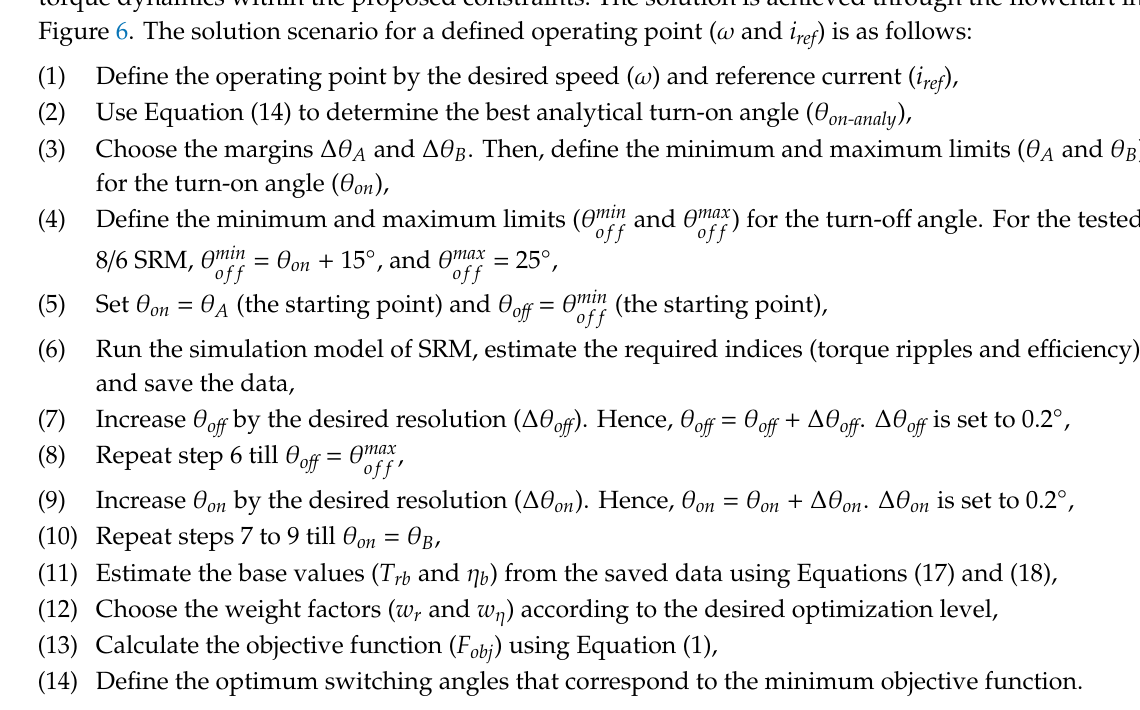
Figure 7. The optimum excitations: ( a ) the θ on angles; ( b ) the θ off angles.